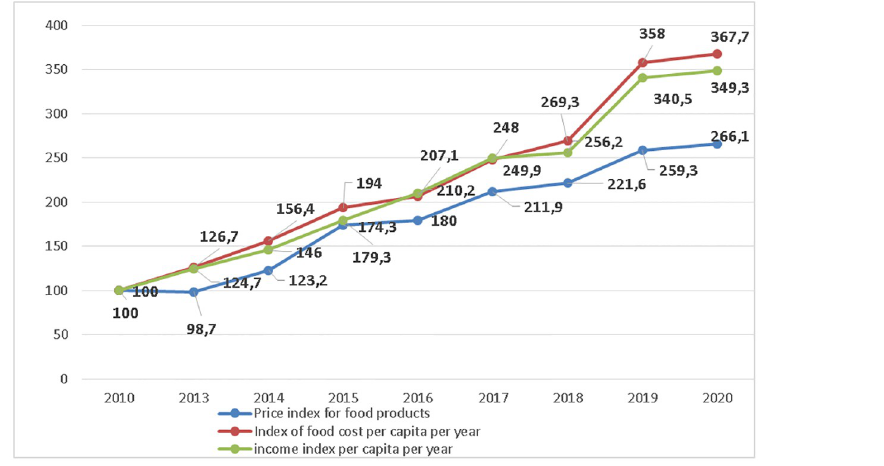
Fig 4. Price indices, % by 2010. Source: developed by the authors according to [54, 56–60].